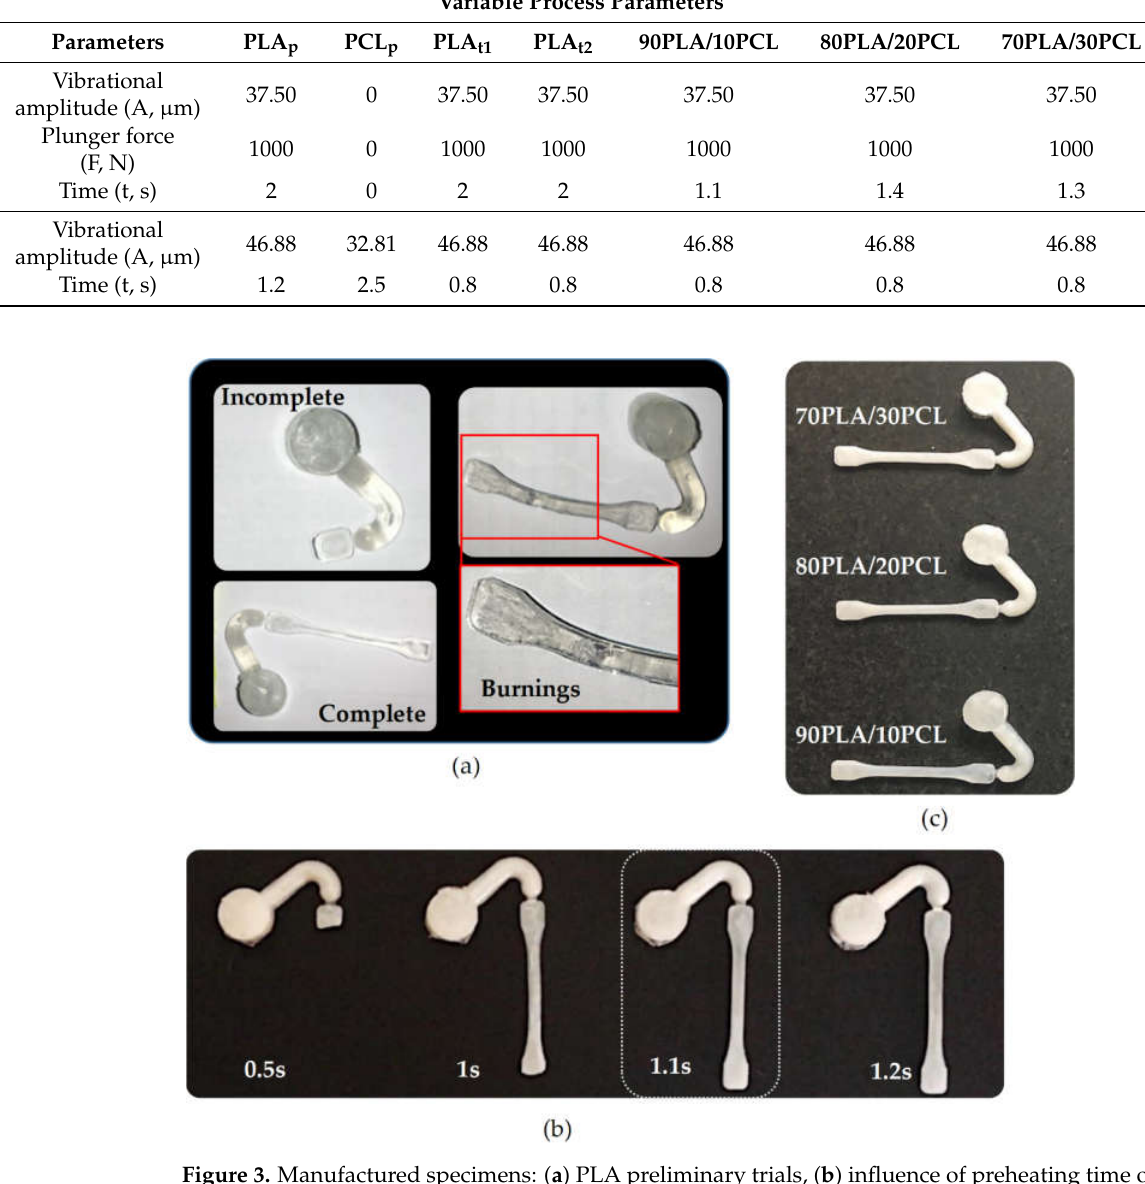
Figure 3. Manufactured specimens: ( a ) PLA preliminary trials, ( b ) influence of preheating time on 90PLA/10PCL specimens and ( c ) specimens of PLA/PCL